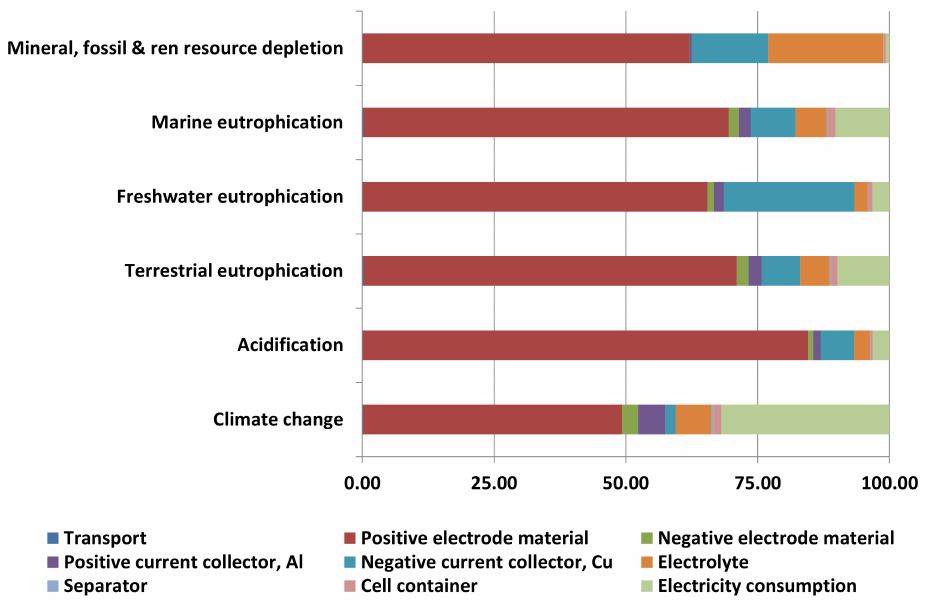
Figure 6. Life cycle impacts of NMC 532 battery cell production, broken down into key